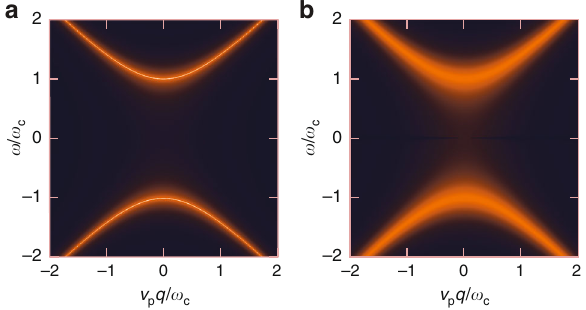
¼ 0 : 15 T, (cid:2) B ¼ 0 T, and m m